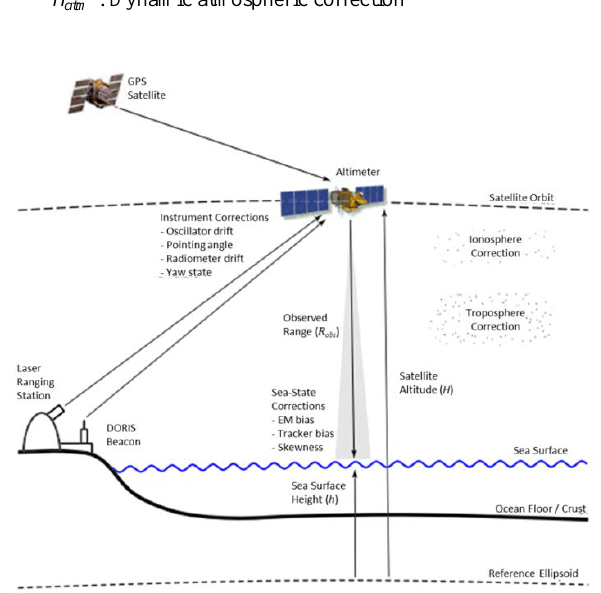
Figure 3. Schematic view of satellite altimeter measurement